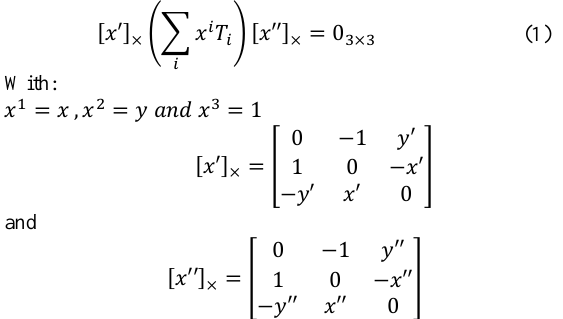
Figure 10. Example of image generated with POV-Ray.